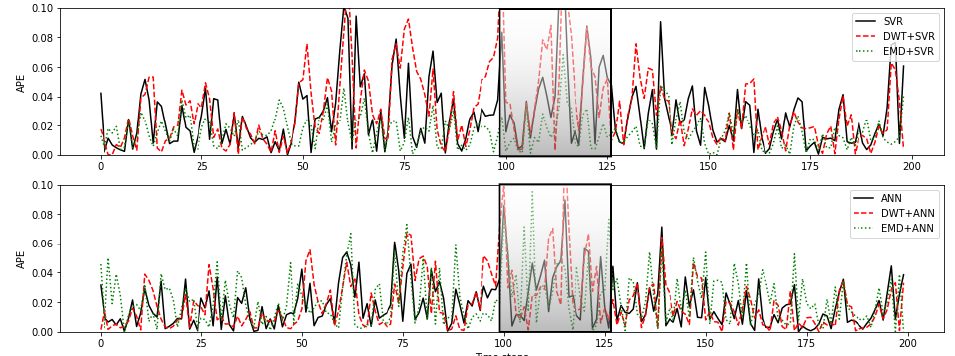
Figure 6. Daily stock return and stock pattern of Tencent.